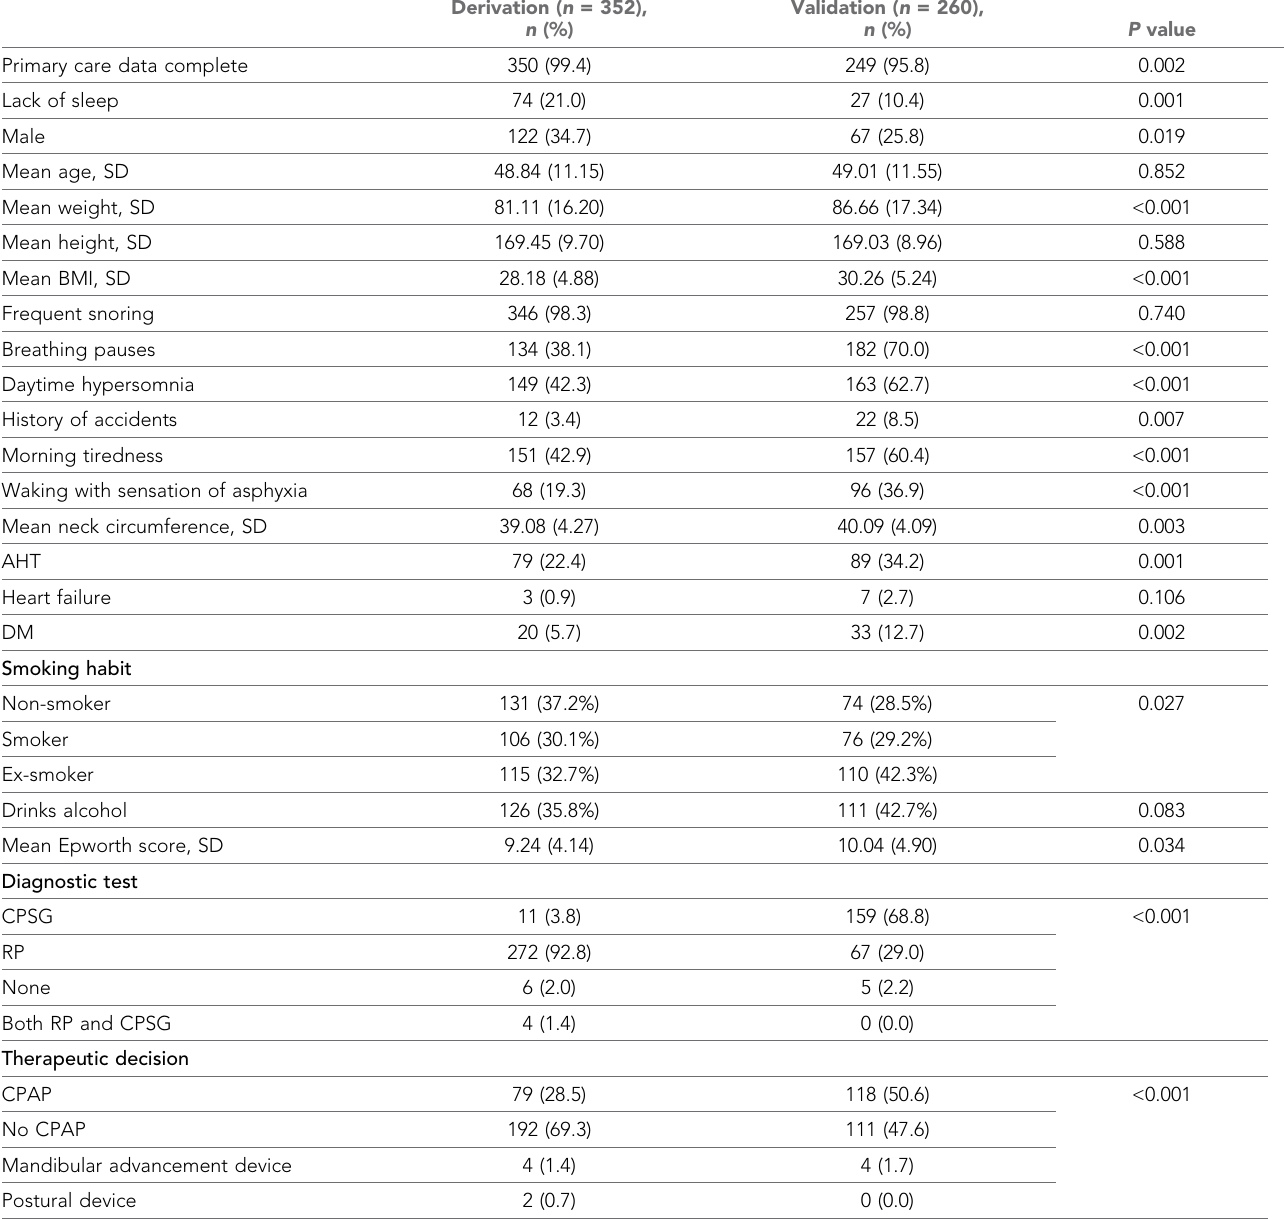
Table 2. Comparison of the derivation and validation